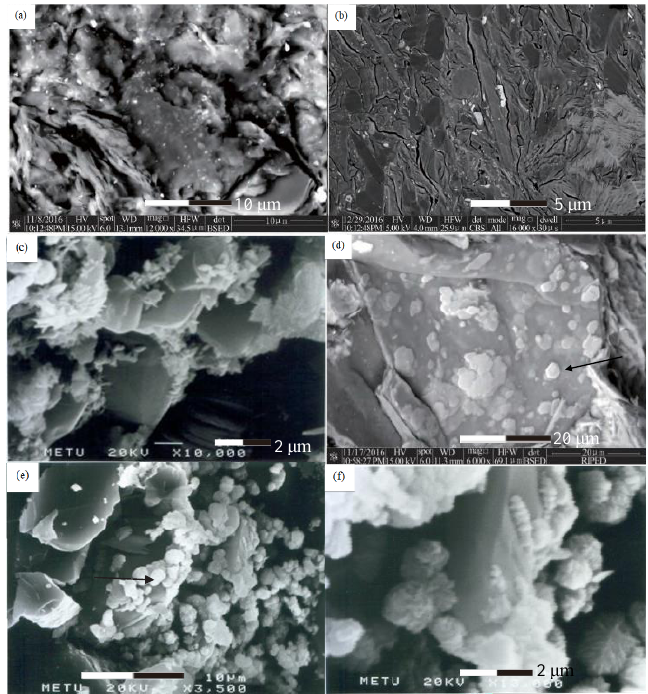
Figure 2. ( a ) Hematite scattered over illite/smectite layers; ( b ) fine and dispersed hematite distributed among clay minerals; ( c ) hematite pigment showing a patchy coating on detrital grains; ( d ) plated hexagonal hematite crystals distributed on the surface of a detrital mineral; ( e ) spherical hematite particles; ( f ) rod-shaped (or bacillus-shaped) hematite particles disseminated on the grain surface. ( a , b , d ) are reprinted with permission from Ref. [47]. 2020, Geoscience; ( c , e , f ) are reprinted with permission from Ref. [44]. 2013, Turkish Journal of Earth Sciences.